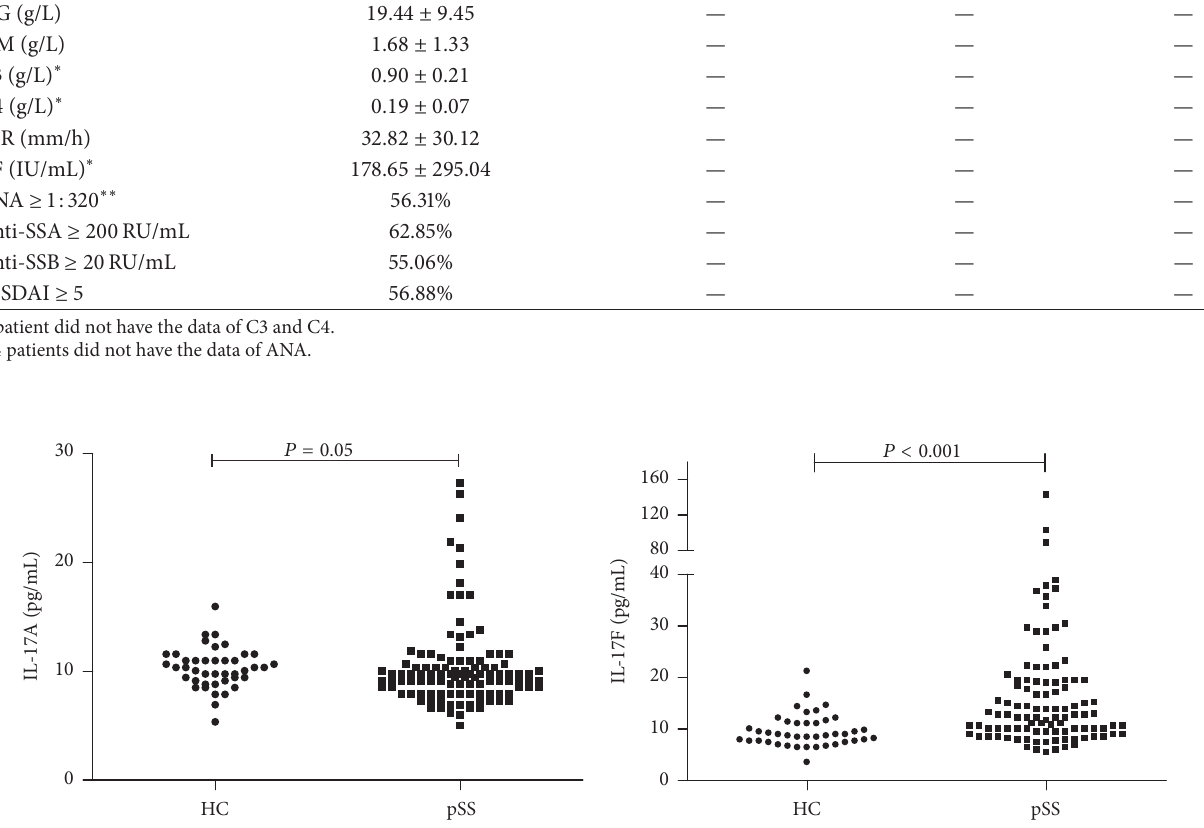
IL-17A-elevated group (IL-17A ≥ 13.8 pg/mL, 𝑛 = 12 ) and IL- 17A-normal group (IL-17A < 13.8 pg/mL, 𝑛 = 97